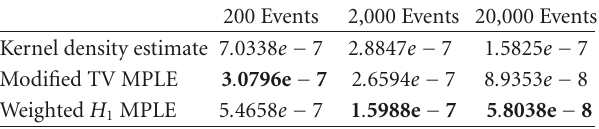
Table 3: This is the L 2 error comparison of the three methods for the Orange County Coastline example shown in Figures 7, 8, and 9. Our proposed methods performed better than the Kernel density estimation